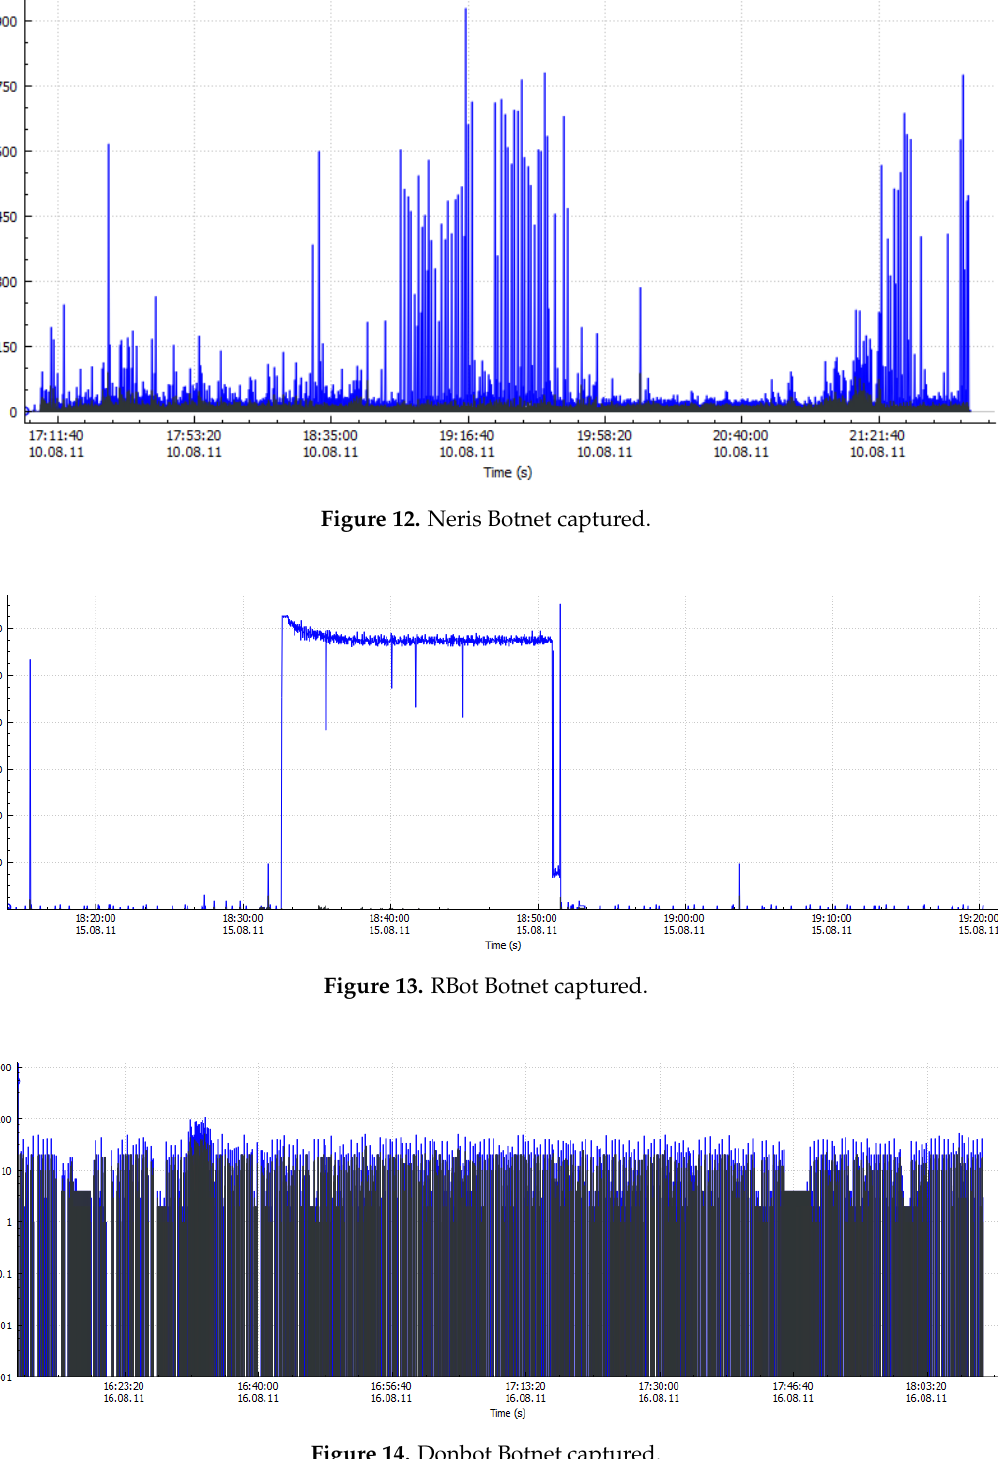
Figure 14. Donbot Botnet